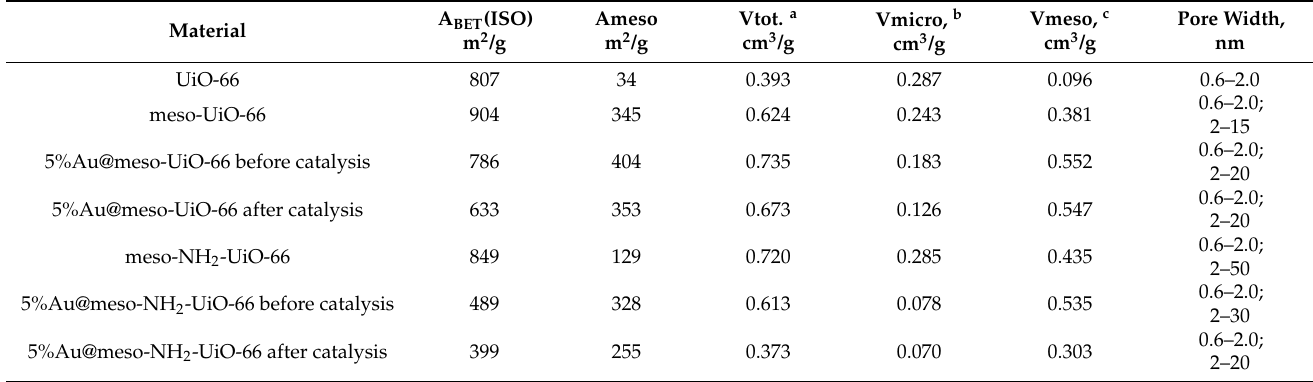
Table 1. Textural characteristics for the meso-UiO-66 and meso-NH 2 -UiO-66 matrices as well as